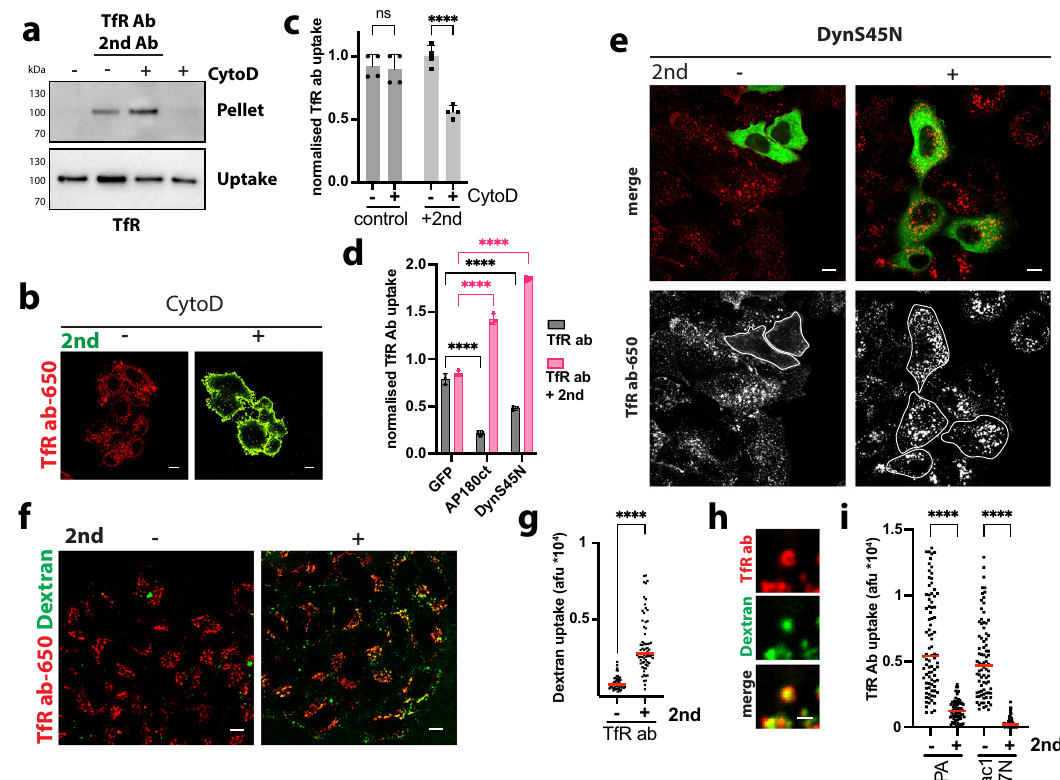
Fig. 4 | Aggregation-dependent endocytosis re-routes transferrin receptor. a Antibody-mediated aggregation and endocytosis of TfR. After surface biotinyla- tion, SkBr3 cells± CytochalasinD (CytoD) were incubated with anti-transferrin- receptor antibody and cross-linking secondary (2nd) antibody for 30min, surface remaining biotin was removed. Samples were processed, as described in the “ Methods ” section and assayed by immunoblot for transferrin receptor (TfR). b , c Cross-linked transferrin-receptor endocytosis requires actin polymerisation. SkBr3 cells± CytoD were incubated with dylight650-labelled anti-transferrin- receptor antibody289 (red)±secondaryantibody-AlexaFluor488(green)(2nd)for 30minandanalysedbyconfocalmicroscopy( b )or fl owcytometry( c )means±SD, n =4 independent experiments, ns (non-signi fi cant) P >0.05, **** P <0.0001,